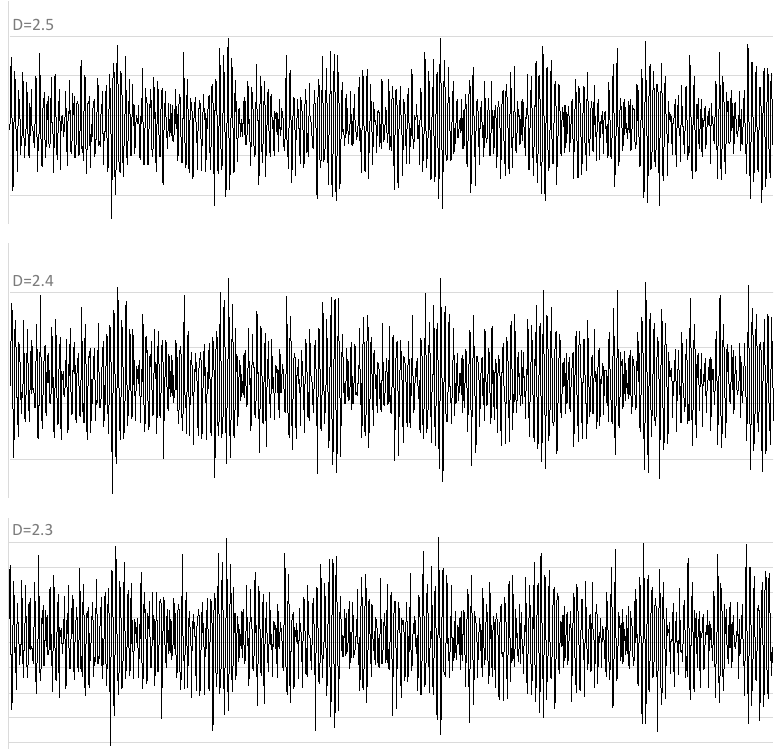
Figure 5. Contour curves for different fractal dimension D.